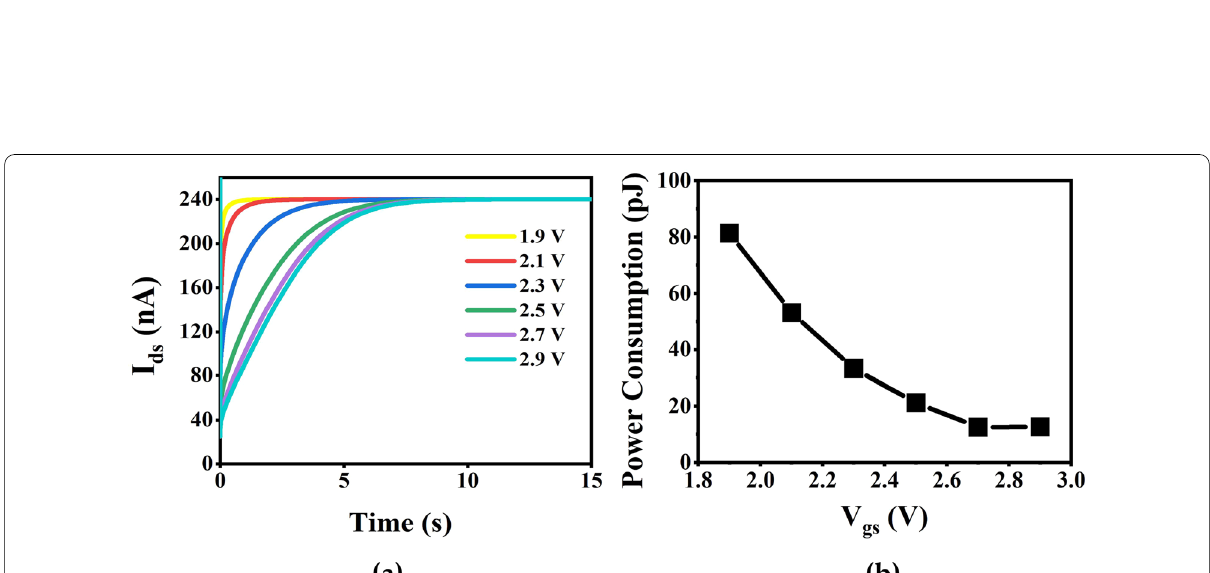
Fig. 5 The PSC with different concentration of traps (10 17 , 10 18 , 10 19 , 10 20 cm − 3 ) in the oxide layer at V ds gate voltage pulses are set at 2 V and 1 ms, respectively